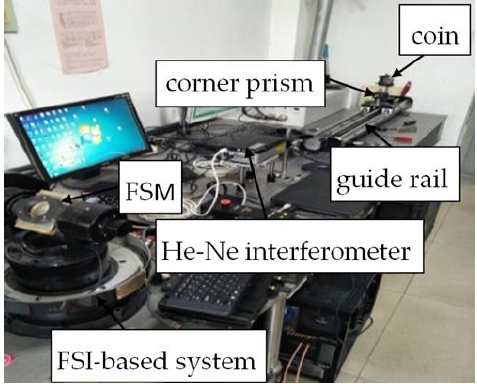
Figure 6. Experiment setup.